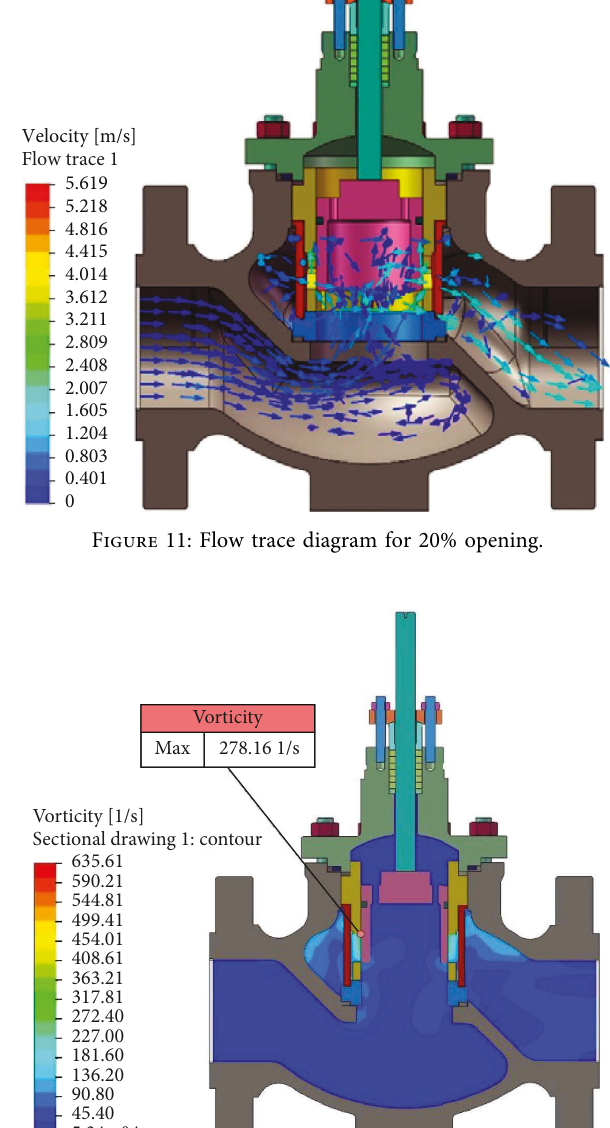
Figure 10: Speed cloud map for 20% opening.